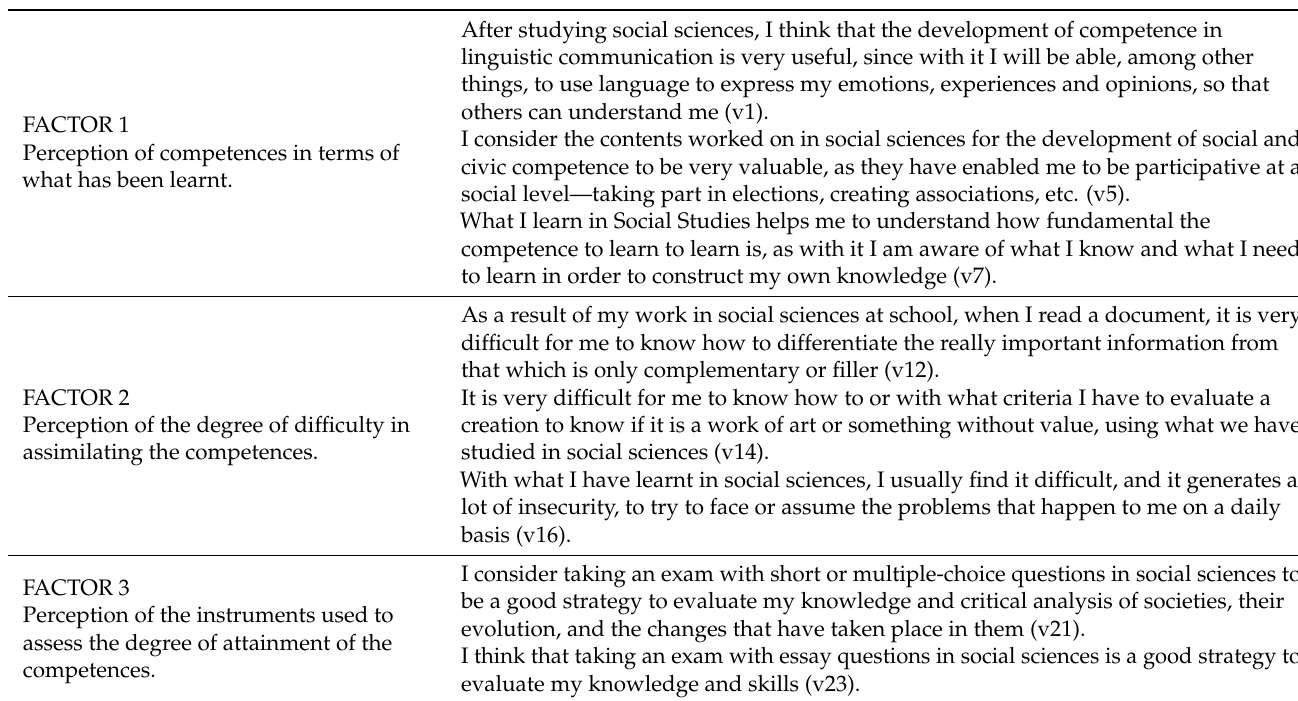
Table 1. Rotated component (factor)